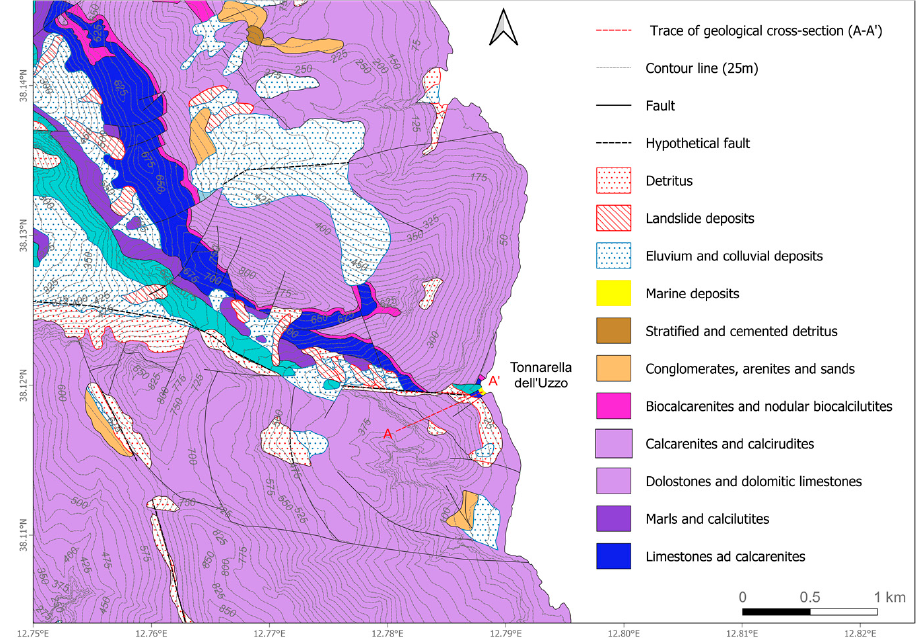
Figure 2. Geological map of the study area.